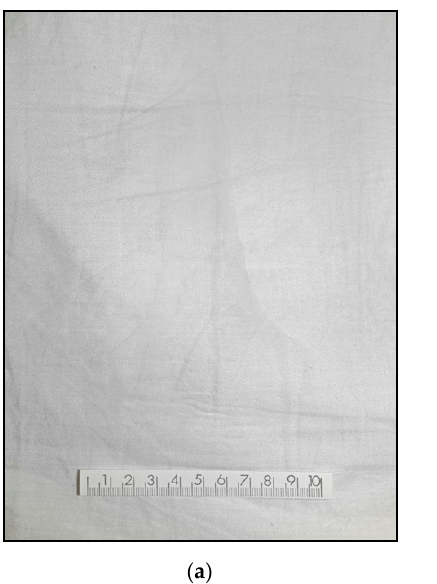
Figure 6. Images of a wall with traces of latent blood under a layer of acrylic paint: ( a ) photographed with a conventional camera and illuminated with white visible light and ( b ) by Invespector illumi- nated with IR radiation 850 nm.